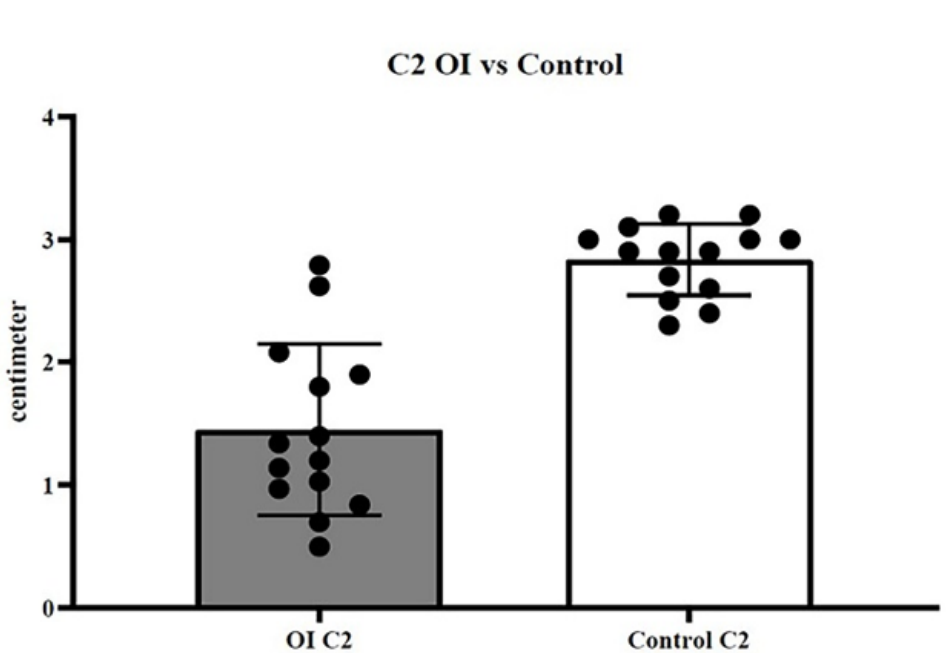
Figure 4. Second dataset (C2 sick population vs. C2 healthy population); the t -test showed a p -value < 0.0001.